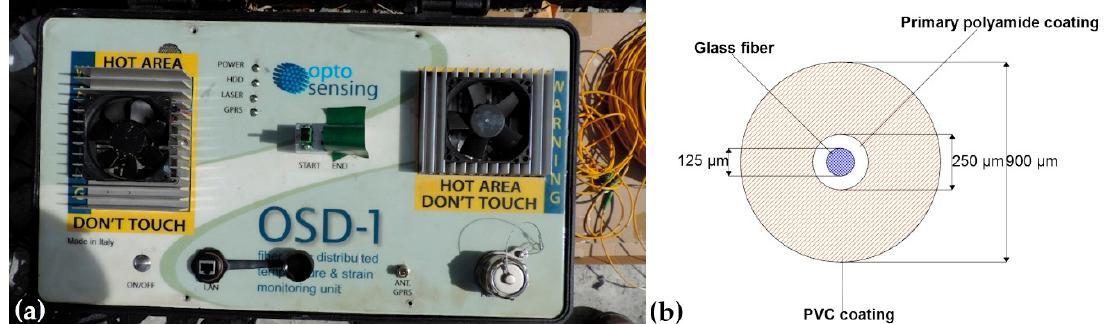
Figure 6. ( a ) Photograph of the OSD-1 measurement unit. ( b ) Cross section of the installed optical fiber sensor with the three different layers (glass fiber, primary polyamide coating and polyvinyl sensor with the three di ff erent layers (glass fiber, primary polyamide coating and polyvinyl chloride chloride coating) and their dimensions. coating) and their